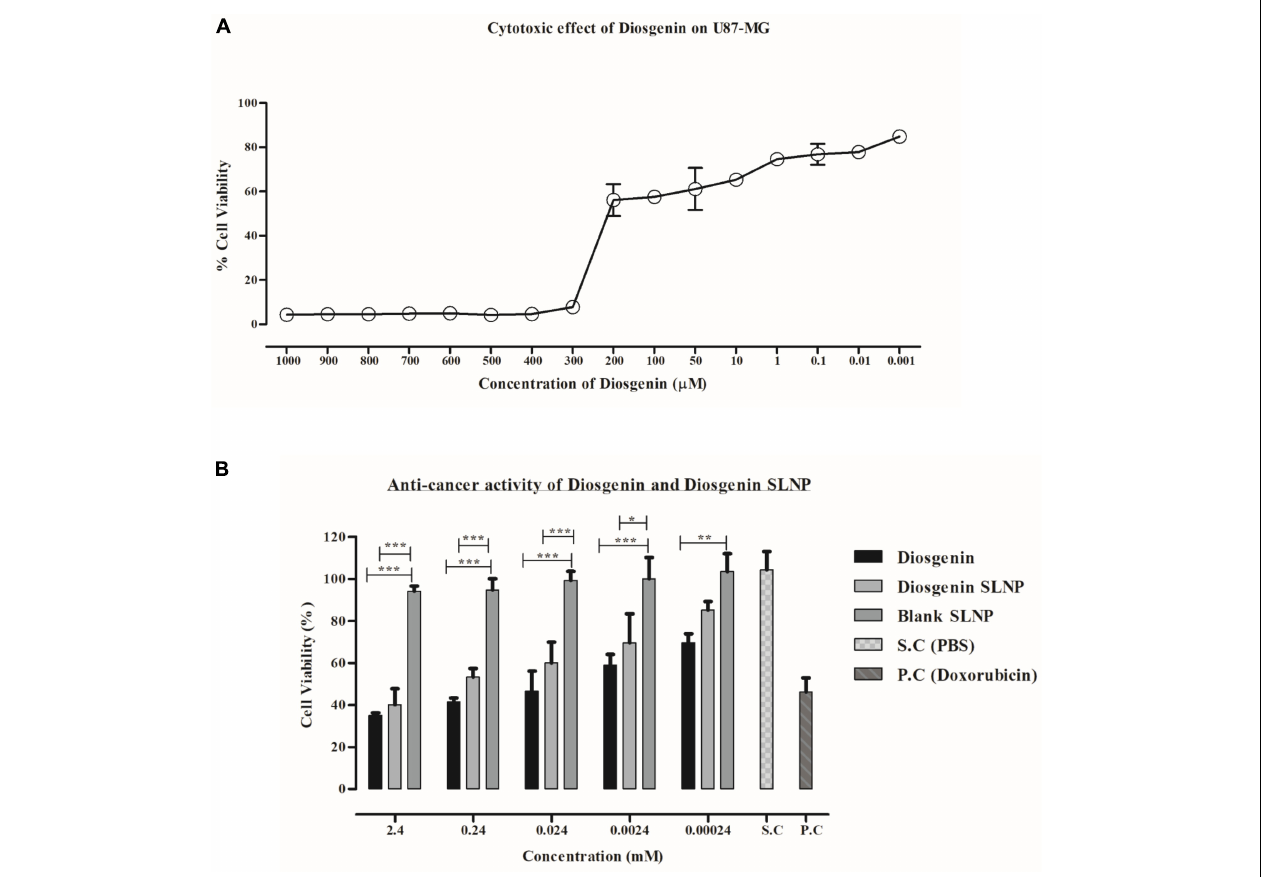
FIGURE 6 | MTT assay. (A) U87 MG cell viability at different concentrations of diosgenin depicting dose-dependent cytotoxic effect and IC 50 value of 18.34 µ M. (B) Effect of diosgenin and diosgenin incorporated solid lipid nanoparticles on U87 cell viability after 24 h showing both to be toxic on cells with p -value less than 0.001 compared with that of blank solid lipid nanoparticles. Results have been presented as mean ± SEM. * p < 0.05, ** p < 0.01, *** p <